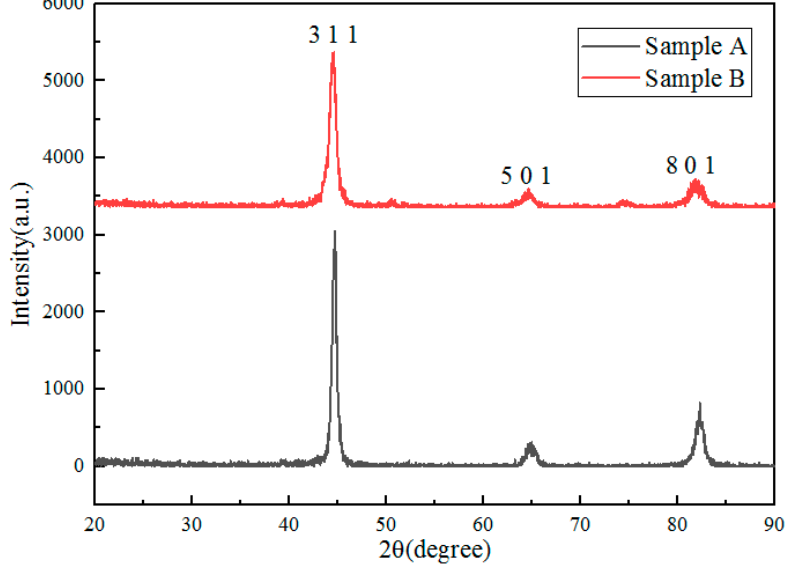
Figure 8. Experimental XRD profiles (relative intensities) of samples A and B.